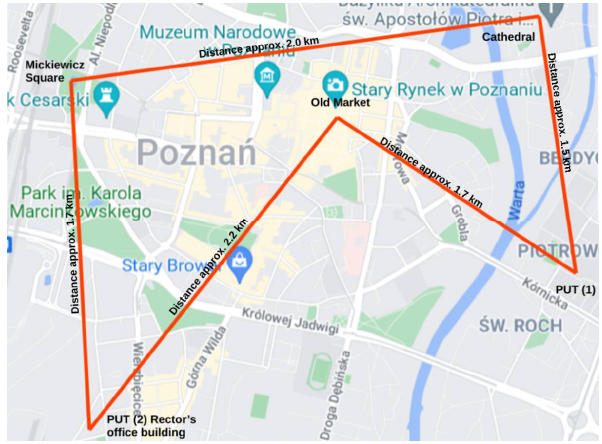
Figure 3. Flight route in Poznań [40].